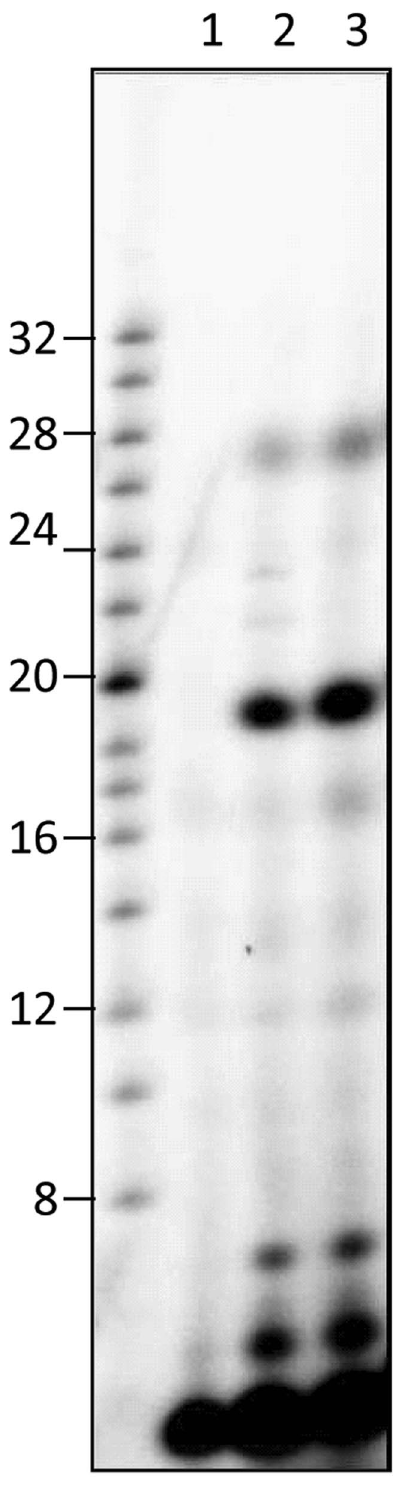
Figure 3. ZIKV RdRp enzymatic activity using oligo(rC) as template. De novo RNA synthesis was performed on oligo(rC) template in the presence of [ α - 32 P]GTP. Reaction products were separated on 12% polyacrylamide denaturing gels (7 M urea). Autoradiography was performed using an imaging plate (Fujifilm) and images were obtained with a FLA-5000 Imaging System (Fujifilm). Markers from Amersham ranging from 8–32 bases were 5 ′ -end labeled and loaded as control on the left of the gel. Lane 1, reaction mix without enzyme. Lanes 2 and 3 correspond to the reaction performed with oligo(rC) or oligo(rC) blocked with cordycepin as template,